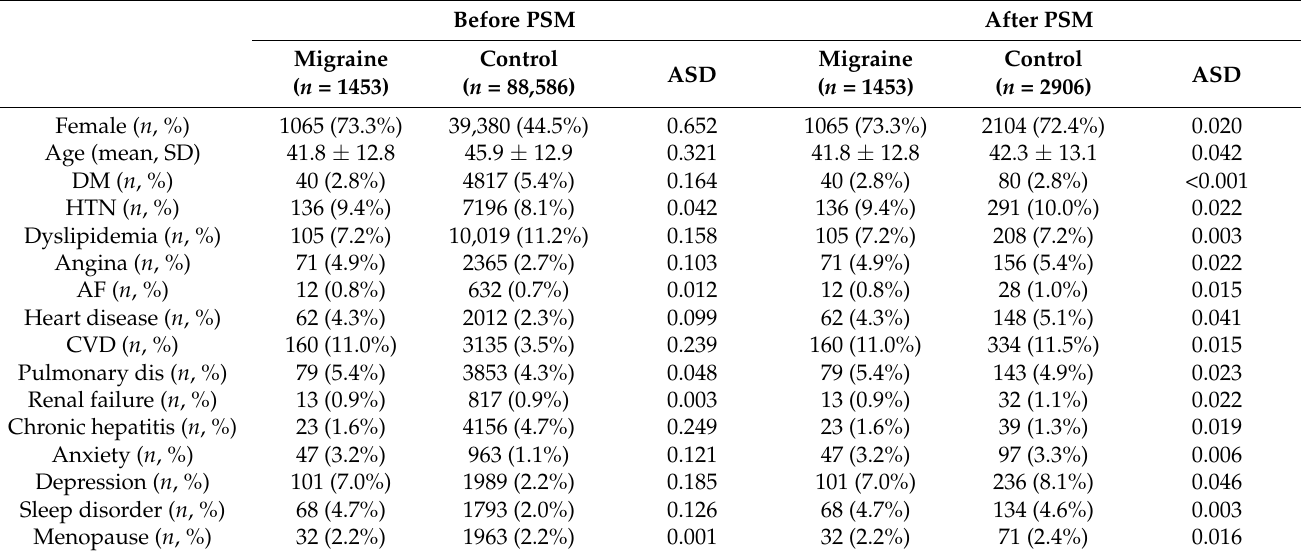
Table 1. Clinical characteristics of the migraine and control groups before and after PSM. Before PSM